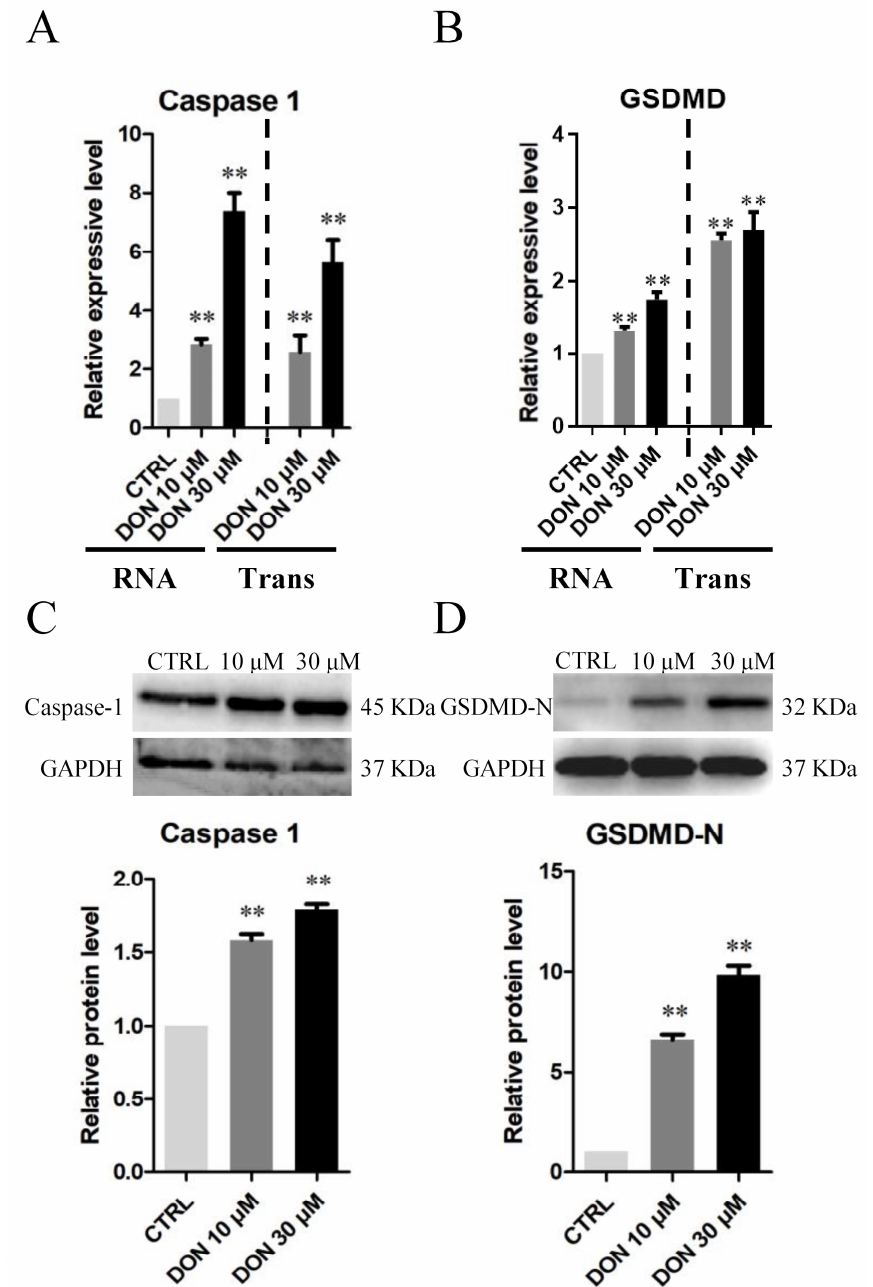
Figure 6. DON exposure affects the mRNA and protein abundance levels of pyroptosis-related genes in cultured Equus asinus SCs. ( A ) Quantitative RT-PCR for Caspase1 transcription factors. The mRNA levels of the genes were normalised to the GAPDH gene. ( B ) Quantitative RT-PCR for GSDMD transcription factors. The mRNA levels of the genes were normalised to the GAPDH gene. ( C ) Protein levels of Caspase1 / GAPDH by Western blot. ( D ) Protein levels of GSDMD -N/ GAPDH by Western blot. The protein levels were normalised to GAPDH . The exposure time was 50 s. The results are presented as the means ± SD. All experiments were repeated at least three times. ** p <